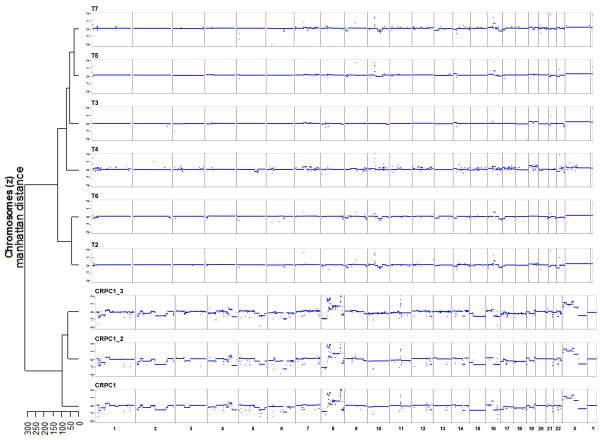
Analyses of tumor and serial plasma samples from patient CRPC1. DNA was extracted from six different regions (designated as T2-T7) from the primary tumor and separately analyzed by our whole-genome sequencing approach (corresponding histology images are in Additional file 5). The first plasma sample (CRPC1) was obtained 13 years after resection of the primary tumor, the interval between the first and second (CRPC1_2) sample was 7 months and between the second and third (CRPC1_3) 2 months. The patient had stable disease under AD and chemotherapy. Hierarchical clustering (Manhattan distances of chromosomal z-scores) of the plasma samples and the sectors of the primary tumor is shown on the left side, the samples are shown in the corresponding order.